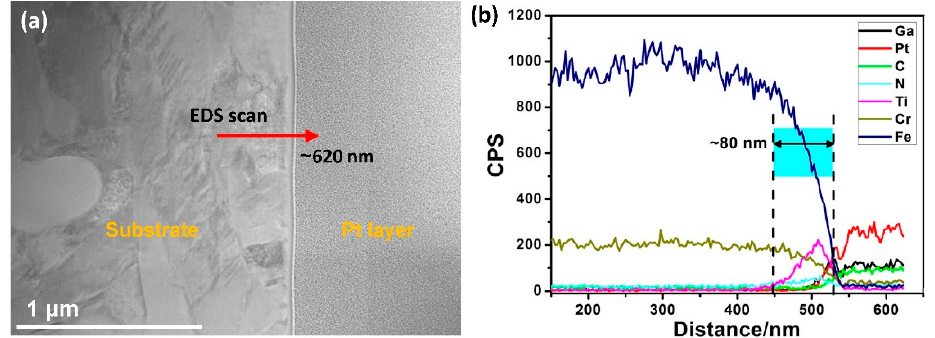
Figure 3. Results of TEM–EDS line analysis of S1: ( a ) TEM image showing the energy-dispersive X-ray spectroscopy (EDS) scan position and ( b ) elemental intensity profiling as a function of scan distance.